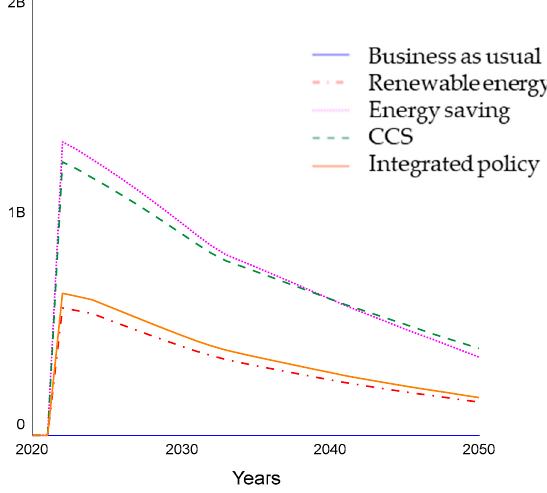
Figure 5. Total subsidy amount (€) 2020 – 2050.